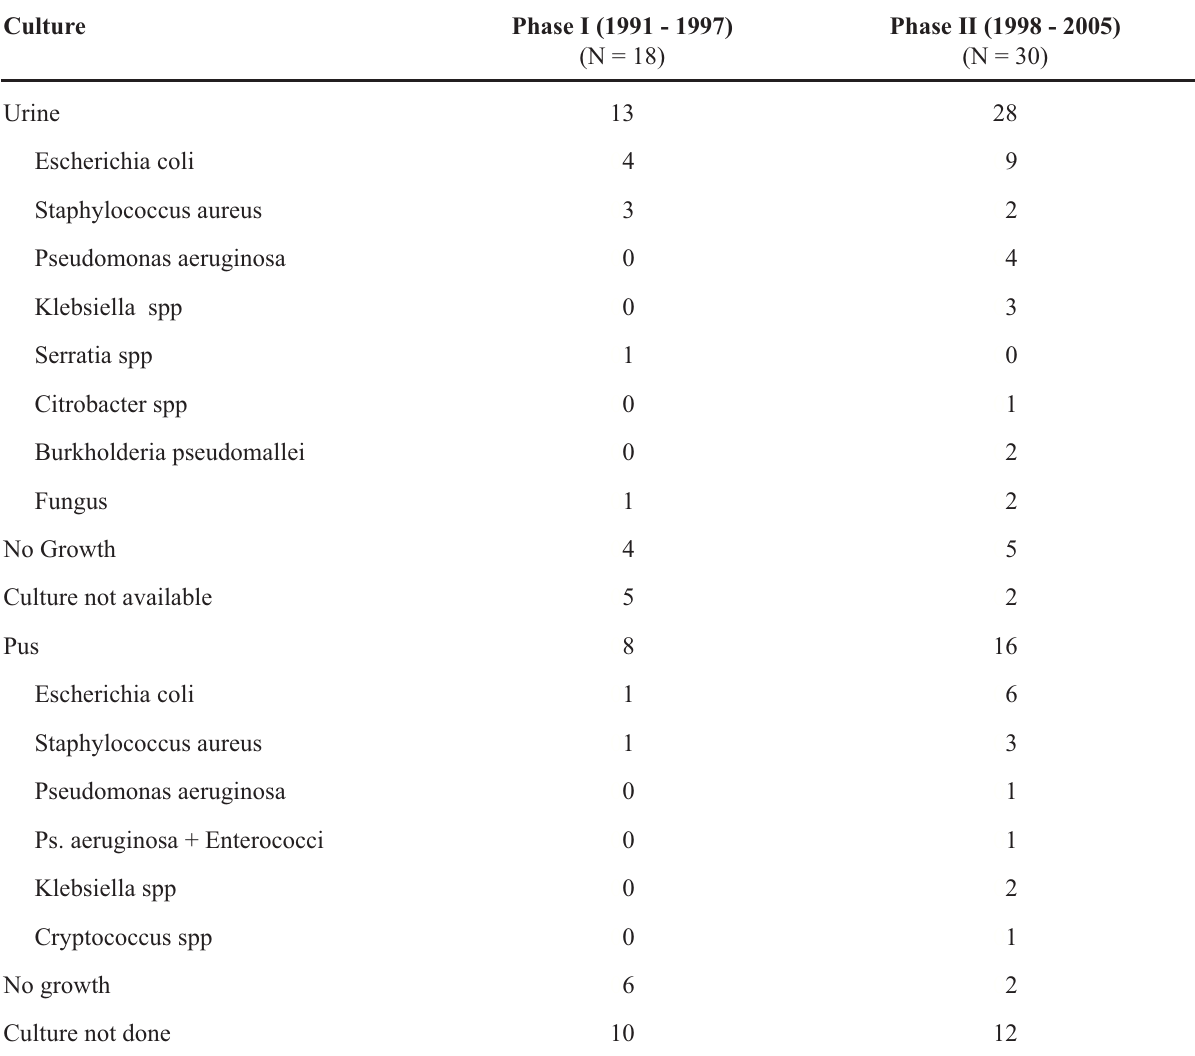
Table 3 – (cid:3)(cid:37)(cid:68)(cid:70)(cid:87)(cid:72)(cid:85)(cid:76)(cid:82)(cid:79)(cid:82)(cid:74)(cid:76)(cid:70)(cid:68)(cid:79)(cid:3)(cid:83)(cid:85)(cid:82)(cid:191)(cid:79)(cid:72)(cid:3)(cid:82)(cid:73)(cid:3)(cid:88)(cid:85)(cid:76)(cid:81)(cid:72)(cid:3)(cid:68)(cid:81)(cid:71)(cid:3)(cid:83)(cid:88)(cid:86)(cid:3)(cid:70)(cid:88)(cid:79)(cid:87)(cid:88)(cid:85)(cid:72)(cid:86)(cid:17)